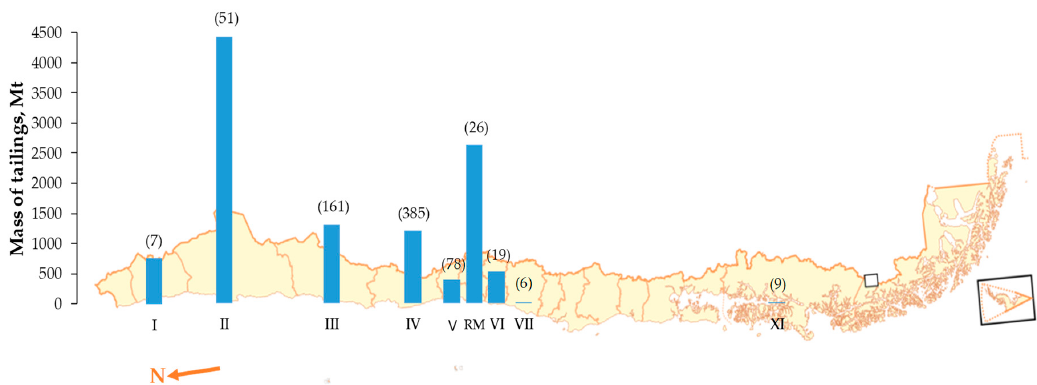
Figure 1. Discarded tailings in Chile are significantly predominant in the northern. The numbers in parenthesis denote the quantity of tailing deposits in each region of Chile [3].